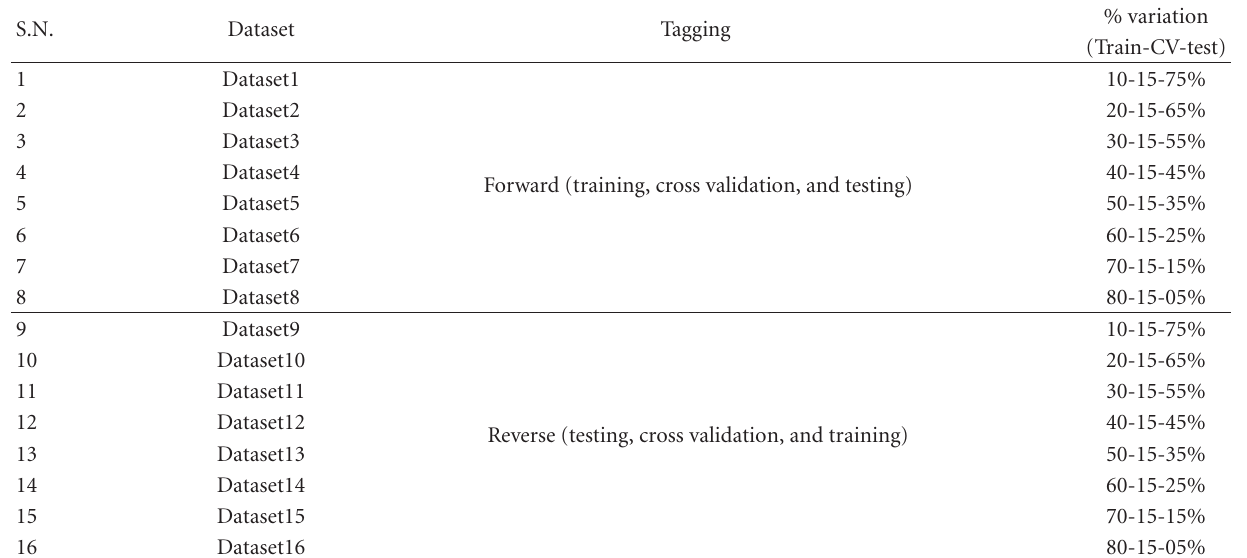
Table 1: EMG signal datasets used for NN-based models. Total number of samples = 2000. (a) Datasets based on forward and reverse tagging and %